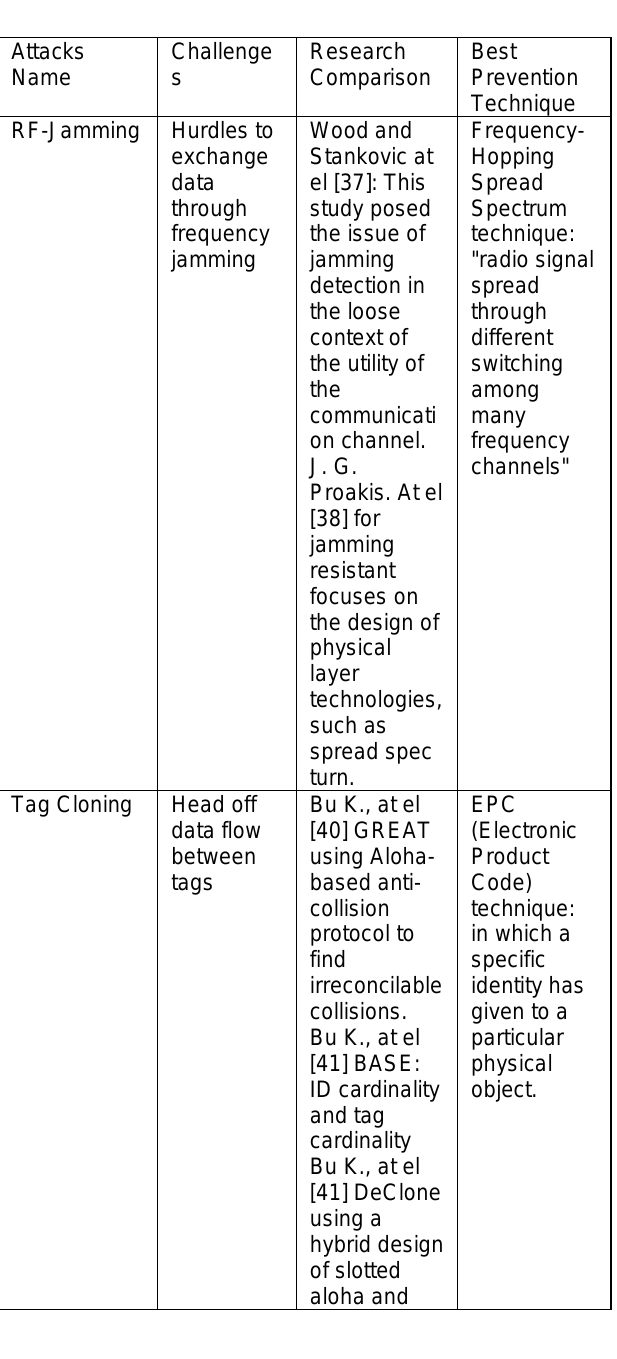
Table 2. Summary of Perception Layer Attacks and its Prevention